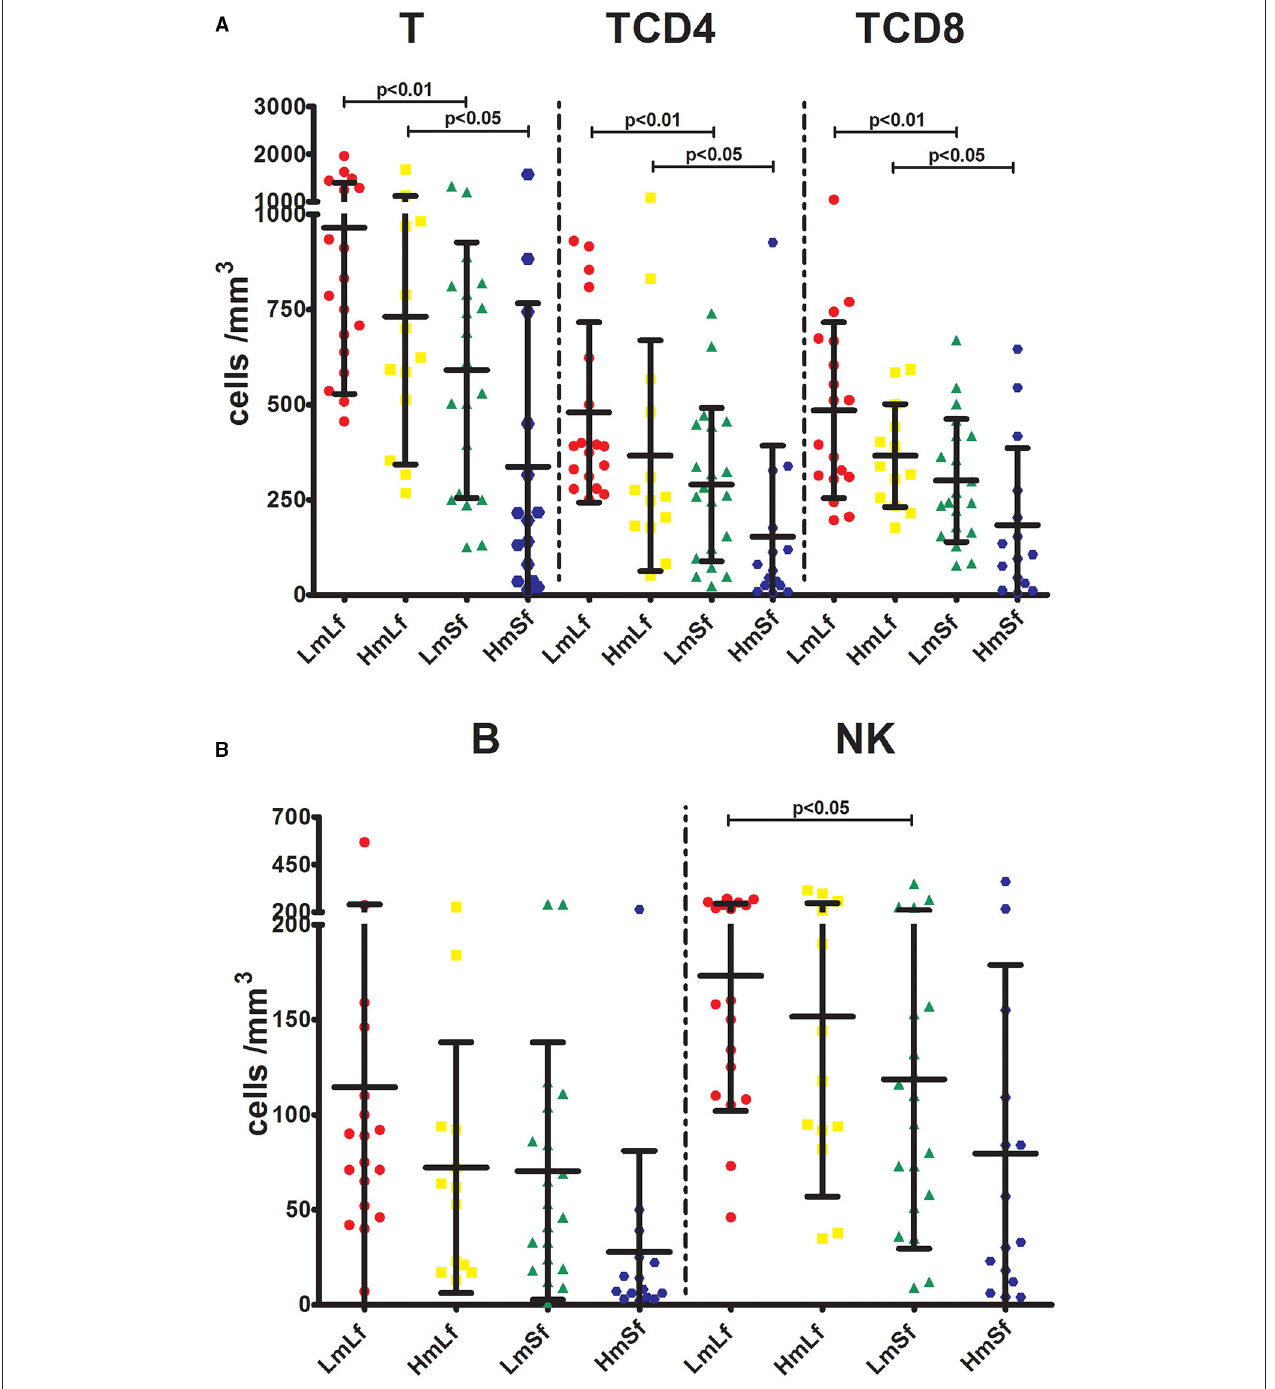
FIGURE 3 | Effects of the MELD score and the follow-up period on the absolute counts of lymphocyte subpopulations following liver transplantation. Comparison of the absolute counts of T, TCD4, and TCD8 (A) , and NK (B) among LmLf ( n = 18), HmLf ( n = 13), LmSf ( n = 20), and HmSf ( n = 15). Bars represent mean and SD. MELD, model for end-stage liver disease; T, CD3 + T cells; TCD4, CD3 + CD4 + T cells; TCD8, CD3 + CD8 + T cells; B, CD19 + B cells; NK, CD56 + CD16 + natural killer cells; LmLf, low MELD score ( < 10) and long-term follow-up (28 days − 3 months); HmSf, high MELD score ( ≥ 20) and short-term follow-up ( < 28 days); HmLf, high MELD score and long-term follow-up; LmSf, low MELD score and short-term follow-up.